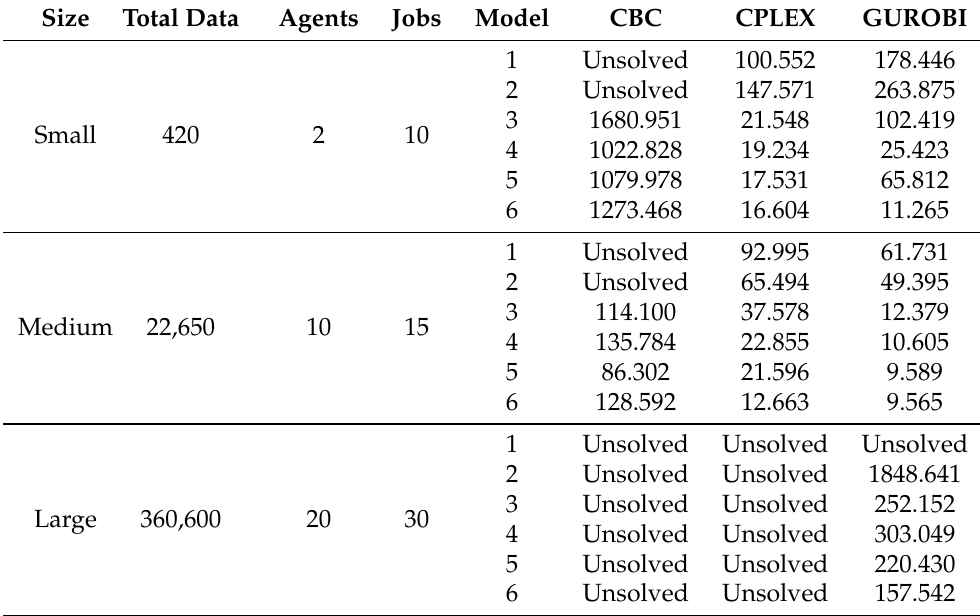
Table 3. Average times (in seconds) for different instances, models and